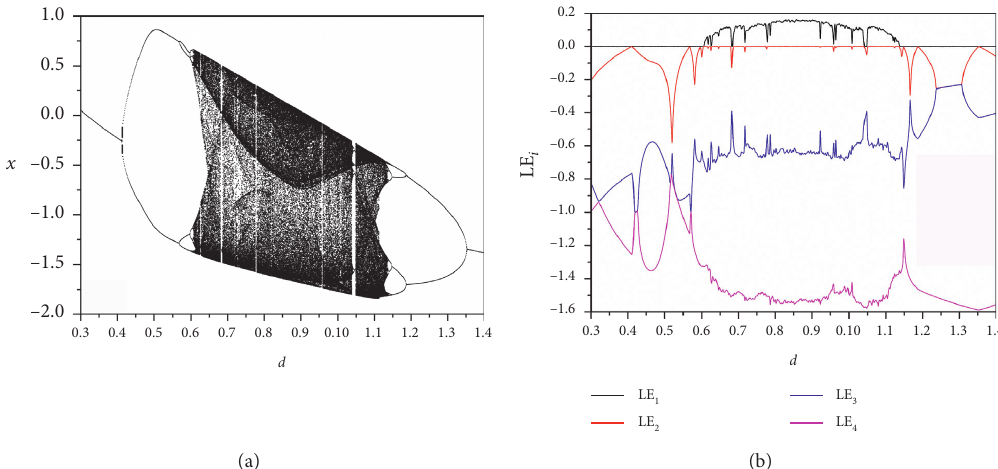
Figure 3: (a) Bifurcation diagram of x versus d and (b) the spectrum of system’s Lyapunov exponents, for a � 1.4 , b � 0.3, and c � 1.4 and ) � (0.1, 0.2, 0.3, initial conditions ( x 0 , y 0 , z 0 , w 0